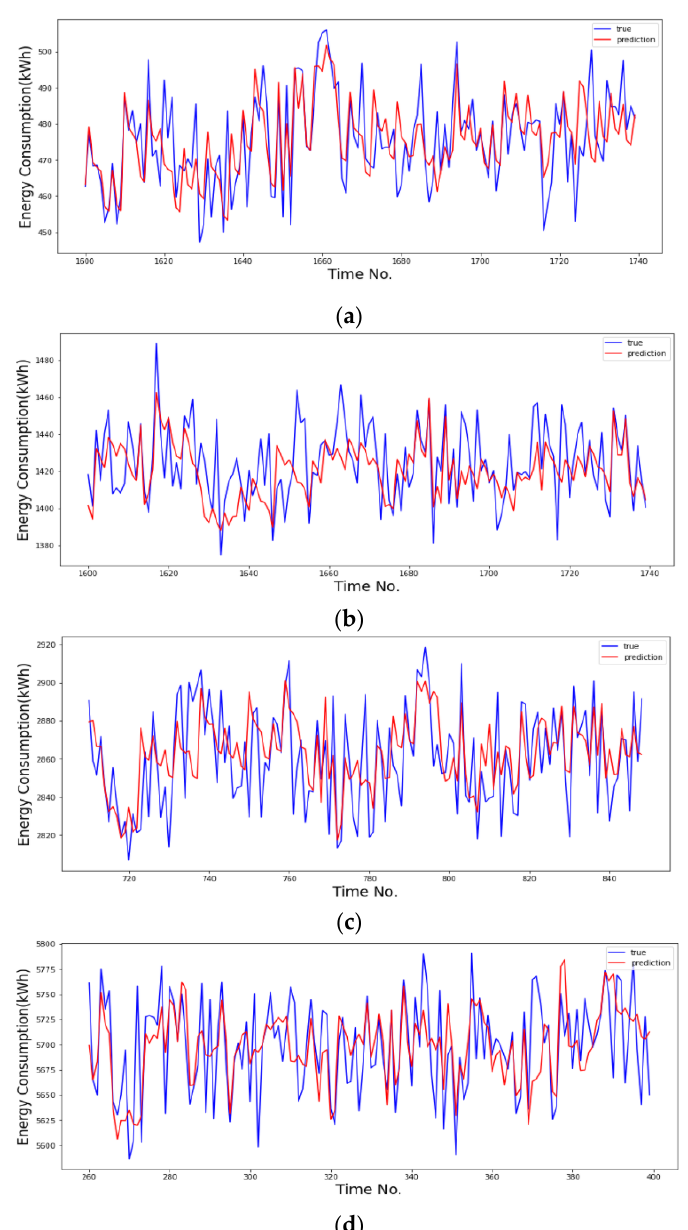
Figure 11. The continuous prediction of STDLN for all datasets of Node XW3. ( a ) 5 min set; ( b ) 15 min set; ( c ) 30 min set; ( d ) 60 min set.